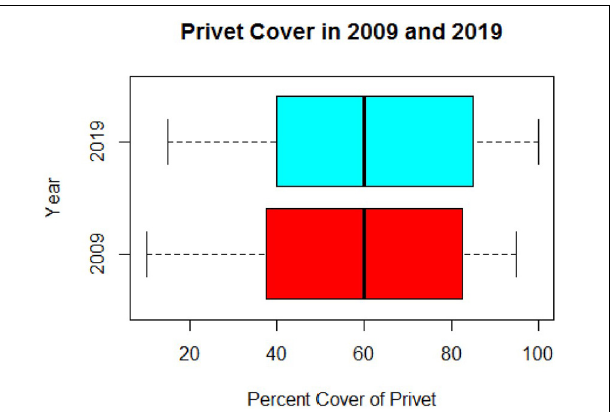
FIGURE 1 | Boxplot of mean estimated percent Chinese privet cover in 2009 and 2019 at the LSU AgCenter Botanic Gardens Forestry Research Area. A Welch Two-Sample T -test reveals there is no significant difference in mean cover between years ( α = 0.05, P =